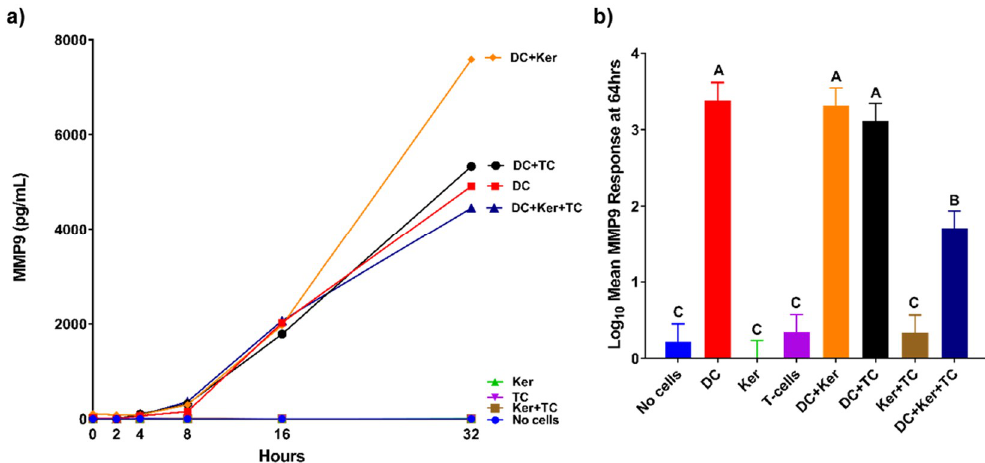
Figure 4. ( a ) MMP9 responses of single cell and co-cultures when treated with HagB ( n = 3). HagB was added at Time 0 to single-cell cultures and co-cultures of T-cells (TC), GE keratinocytes (Ker), and dendritic cells (DC). MMP9 concentrations were determined at 0, 2, 4, 8, 16, and 32 h. The MMP9 responses from the HagB diluent were subtracted from the HagB-induced MMP9 responses. ( b ) MMP9 responses to HagB at 64 h ( n = 9). The MMP9 responses from the HagB diluent were subtracted from the HagB-induced MMP9 responses. A two-way fixed effect ANOVA was fit to log-transformed concentrations of MMP9. Pairwise group comparisons were conducted using the post-hoc Tukey’s honest significance test. A 0.05 level was used determine statistically significant differences between groups. Shared letters above bars indicate the groups are not statistically different from one another ( p > 0.05), while differing letters indicate significantly different mean values ( p < 0.05).